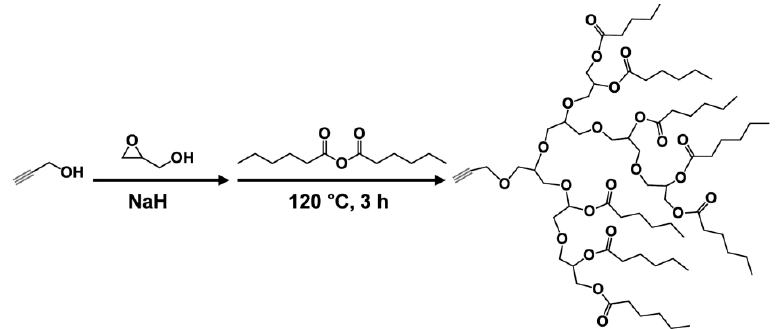
Figure 26. Synthesis internally plasticized PVC with alkynylation EAMR-DOPO.